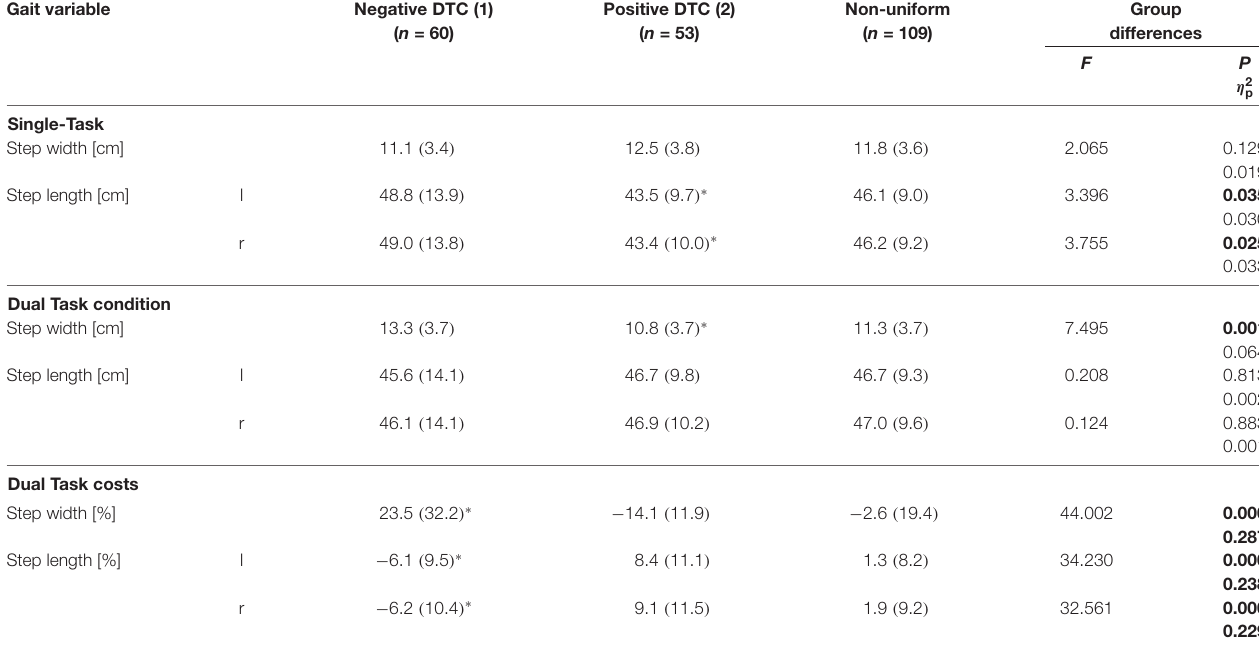
TABLE 3 | Comparison of the walking parameters of the different DTC groups. Gait